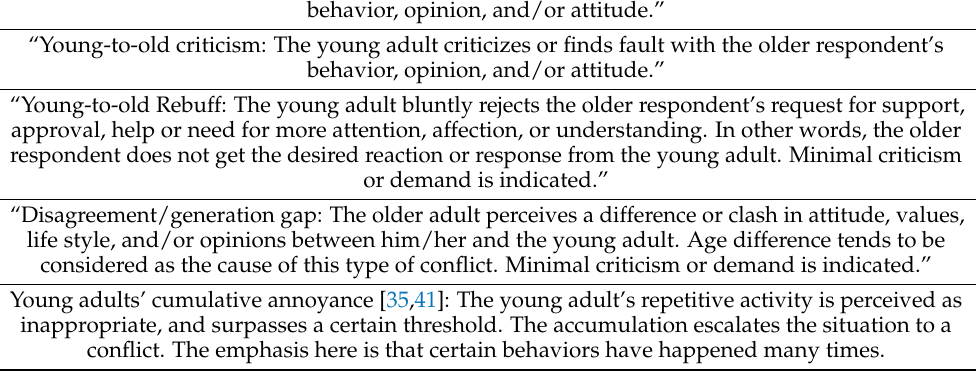
Table 1. Definitions of the intergenerational conflict-initiating factors (adapted from Zhang [13] (p. 305) unless otherwise noted).